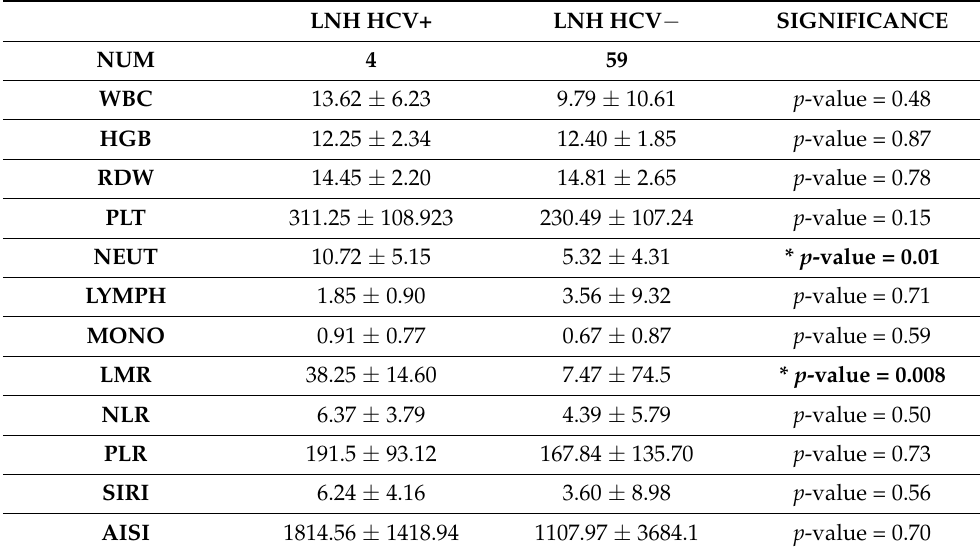
(Table 4). Acetyl-putrescine differed between HCV+ patients compared to HCV − patients in a statistically significant manner (* p -value = 0.008) (Table 5, Supplementary Figure S4). Table 4. Clinical parameters comparison of NHL patients (HCV+ and HCV − ). Unpaired Student’s t -test between HCV+ and HCV − was applied, * p -value < 0.05 as statistically significant. LNH HCV+